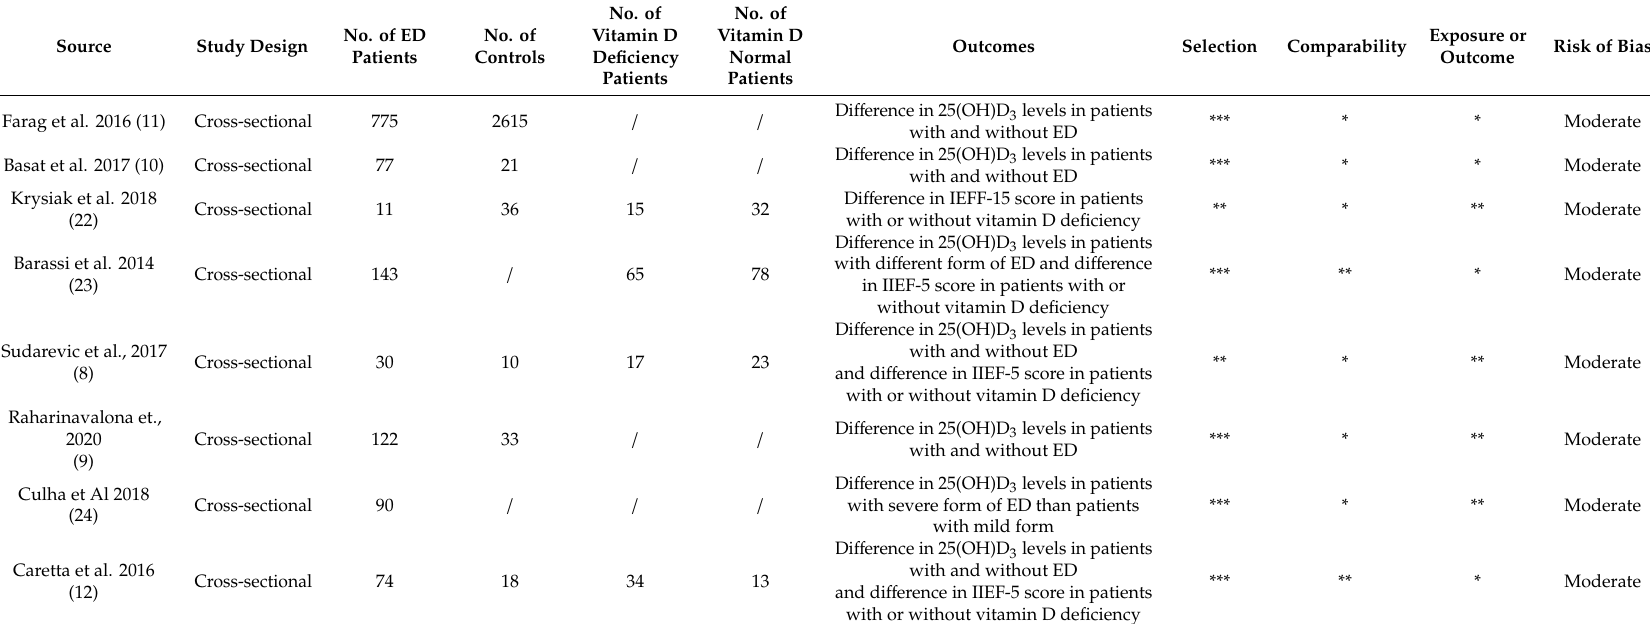
Table 2. Evaluation of the quality of studies using the Newcastle-Ottawa scale